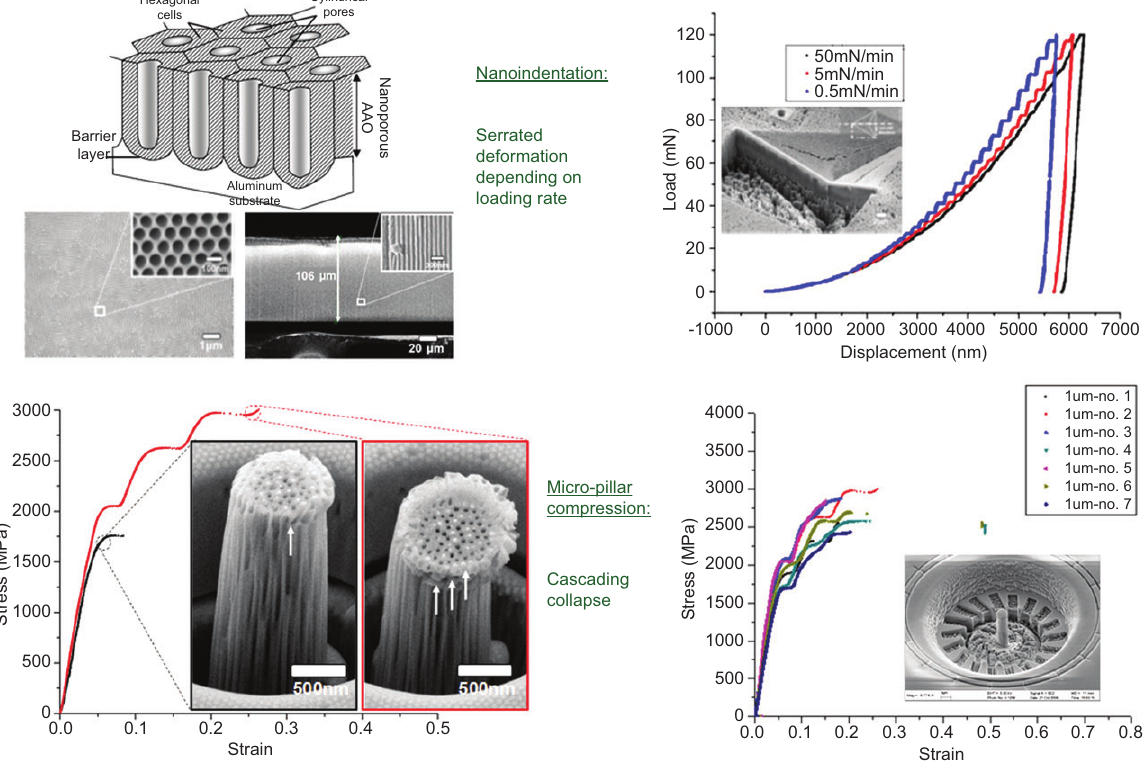
Figure 6 Jerky deformation in anodised alumina with nano-honeycomb structure. Data from refs. [24, 25]